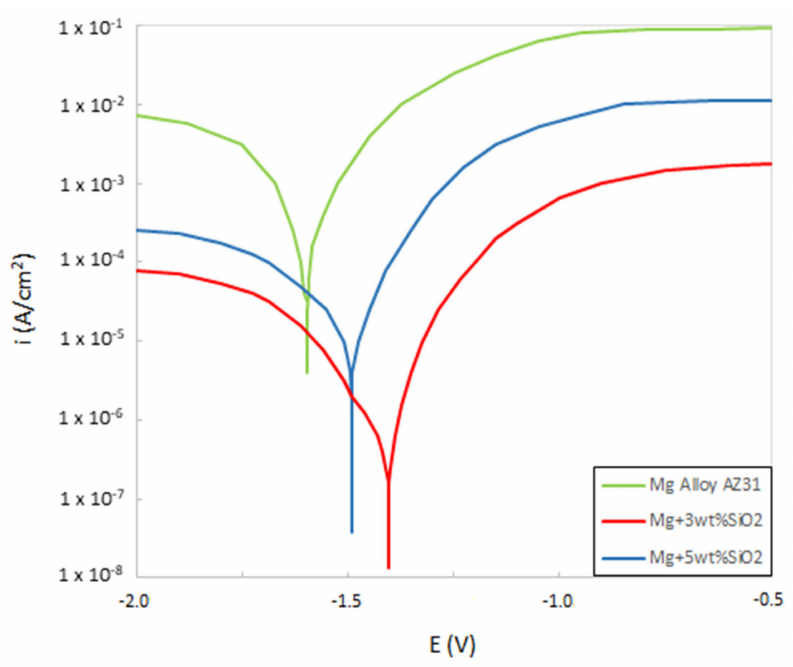
Figure 7. Potentiodynamic curves of Mg alloyAZ31, Mg + 3 wt% SiO 2 and Mg + 5 wt% SiO 2